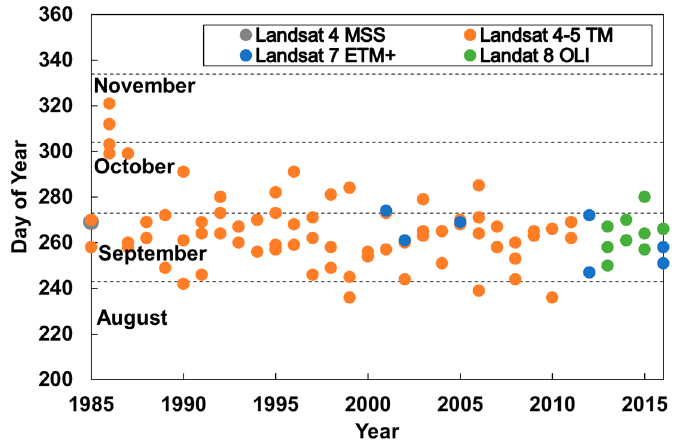
Figure A1. Acquisition dates of Landsat-series images.